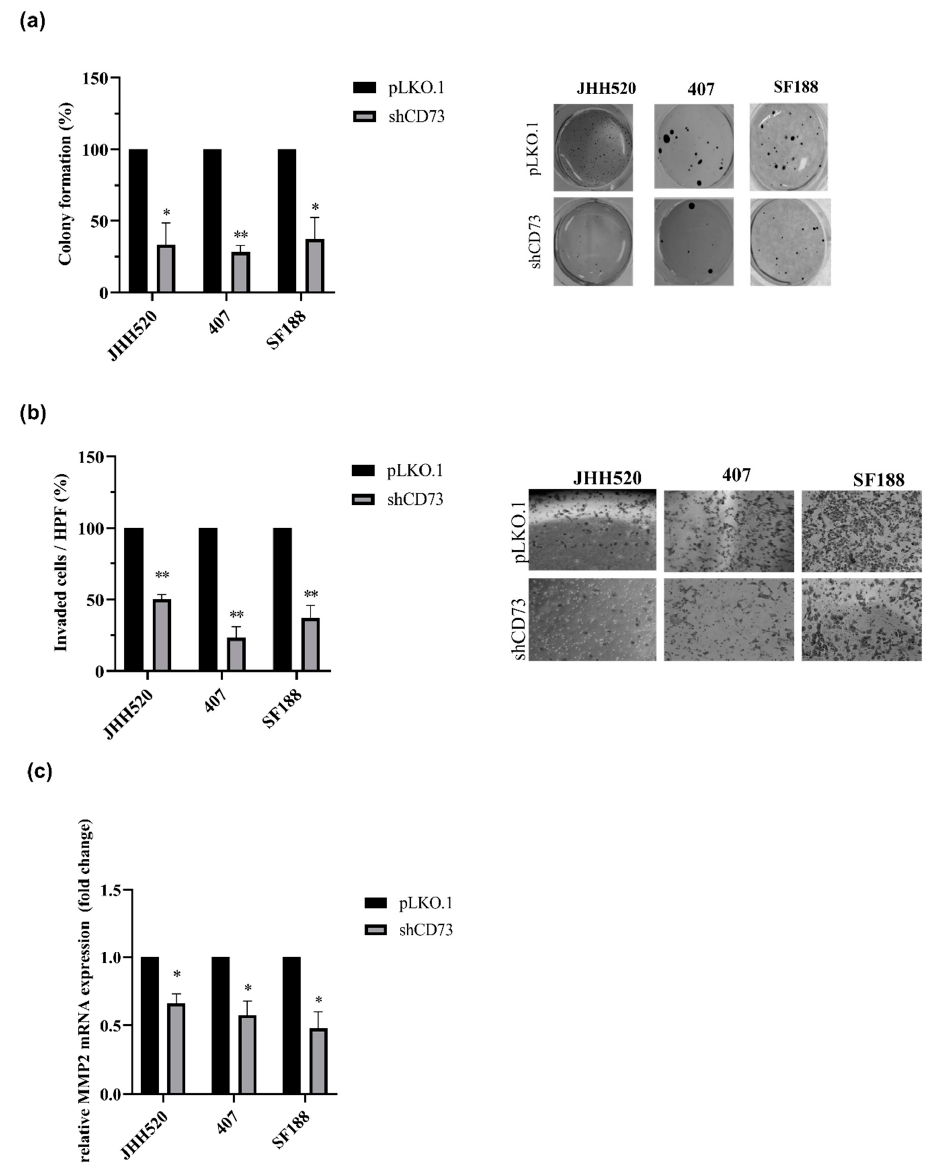
Figure 3. CD73 inhibition reduces clonogenicity and invasion of GSC cultures. ( a ) Knockdown